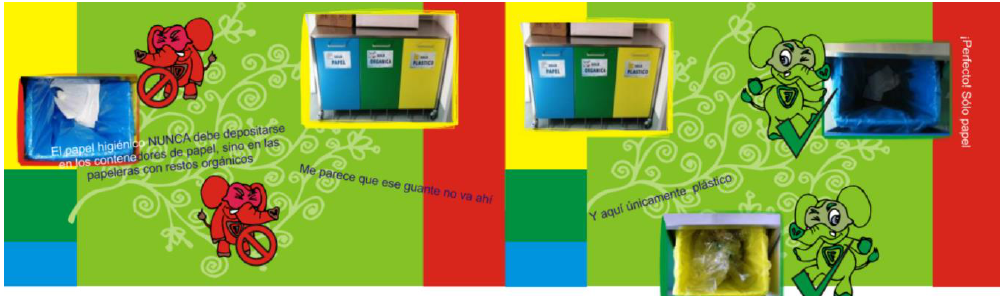
Figure 5. Correct and incorrect segregation actions.